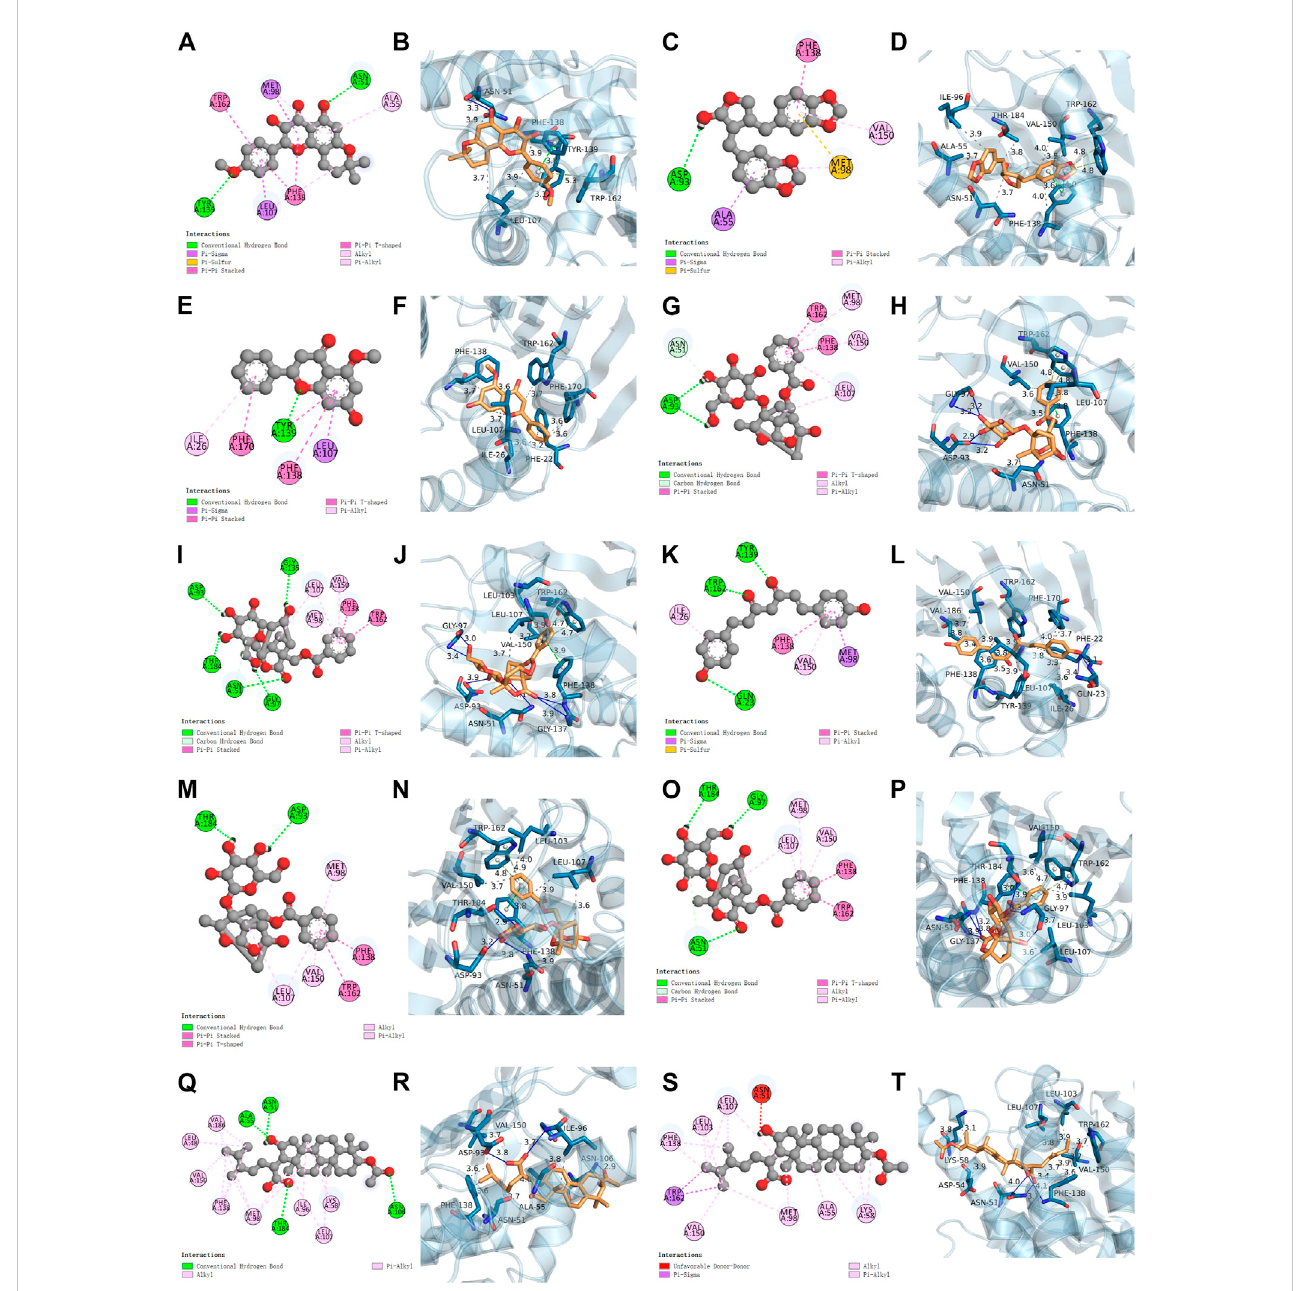
FIGURE 5 Molecular docking results. HSP90AA1 binds with MOL004373 (2D and 3D) (A , B) , MOL013187 (2D and 3D) (C , D) , MOL000228 (2D and 3D) (E , F) , MOL001924(2Dand3D) (G , H) ,MOL001928(2Dand3D) (I , J) ,MOL000940(2Dand3D) (K , L) .EPHA2bindswithMOL001924(2Dand3D) (M , N) ,MOL001928 (2D and 3D) (O , P) , MOL000289 (2D and 3D) (Q , R) , MOL000276 (2D and 3D) (S , T)